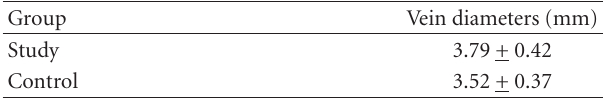
Table 5: Preoperative average internal spermatic vein diameters in study and control